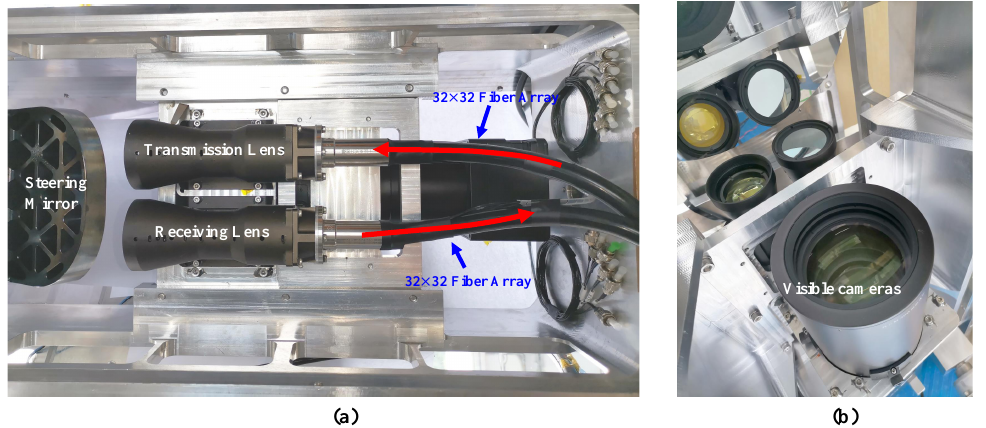
Figure 4. Primary components of LiDAR optical structure. ( a ) top view of LiDAR transmitter and receiver. Note that the fiber arrays are wrapped in black plastic sleeves; ( b ) side view of LiDAR transmitter, receiver, and visible